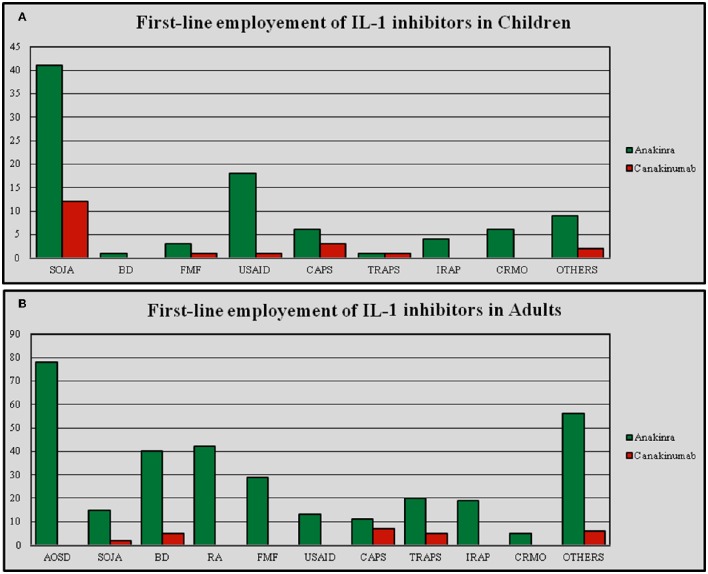
First-line employment of Anakinra and Canakinumab in different indications differentiating between pediatric (A) and adult patients (B). AOSD, Adult Onset Still's Disease; BD, Behçet's Disease; CAPS, Cryopyrin-Associated Periodic Syndrome; CRMO, Chronic Recurrent Multifocal Osteomyelitis; FMF, Familial Mediterranean Fever; IRAP, Idiopathic Recurrent Acute Pericarditis; RA, Rheumatoid Arthritis; SOJA, Systemic Onset Juvenile Idiopathic Arthritis; TRAPS, Tumor Necrosis Factor Receptor-Associated Periodic Syndrome; USAID, Undifferentiated Systemic AutoInflammatory Disease.